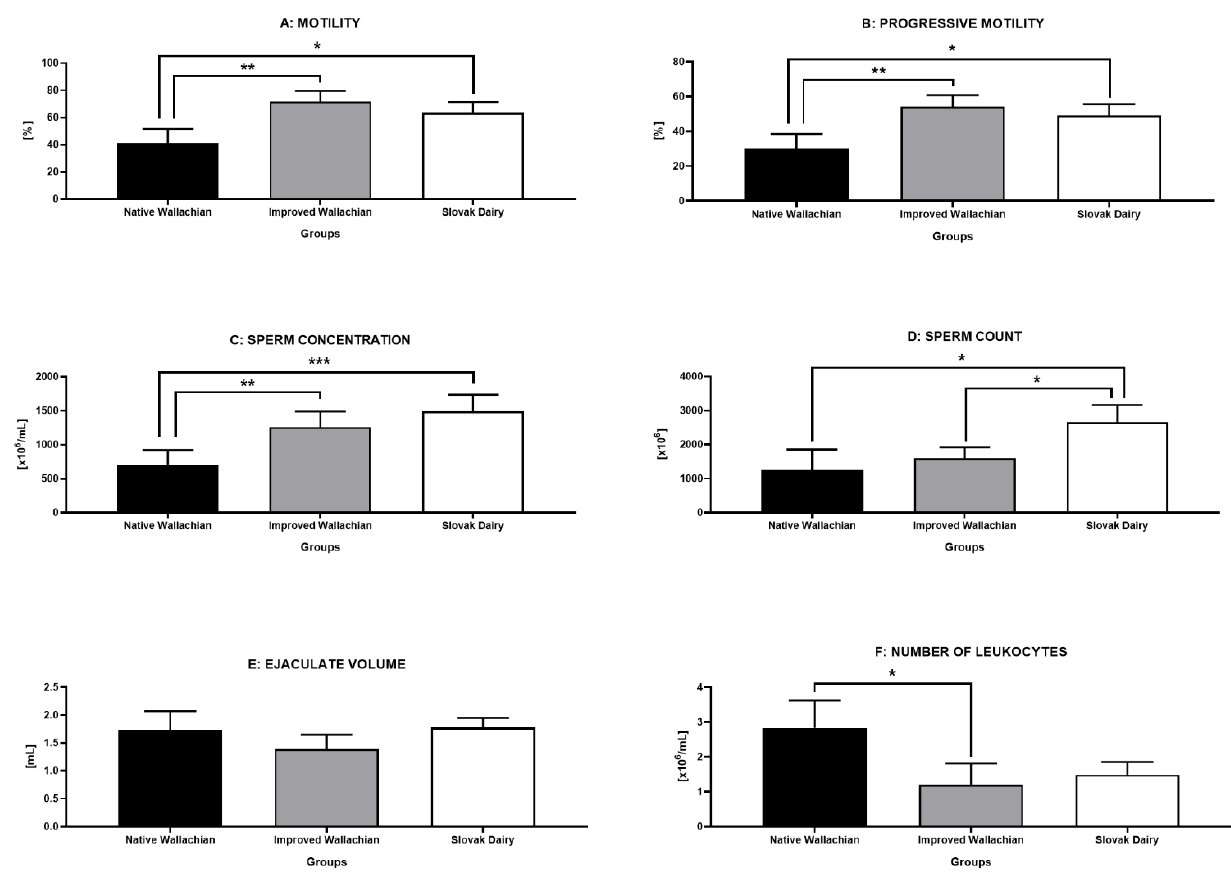
Figure 4. Comparative analysis of standard semen characteristics among the pre-established groups of ram semen samples. * p < 0.05; ** p < 0.01; *** p < 0.001.